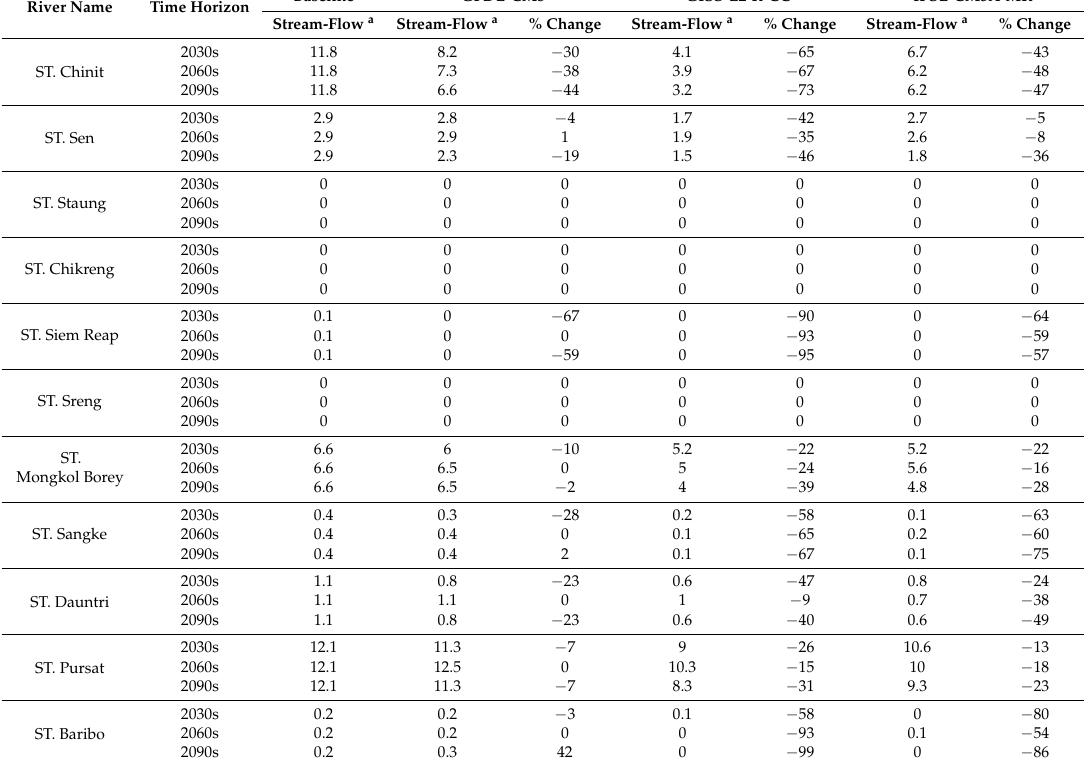
Table 7. Percentage changes in Q 95 for the three GCMs during the three time